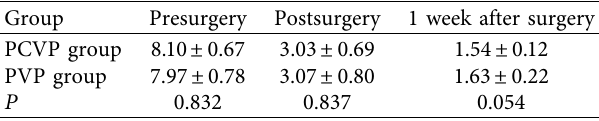
Table 2: Pain VAS scores of patients presurgery, postsurgery, and 1 week and 1 month ( x ± s ,